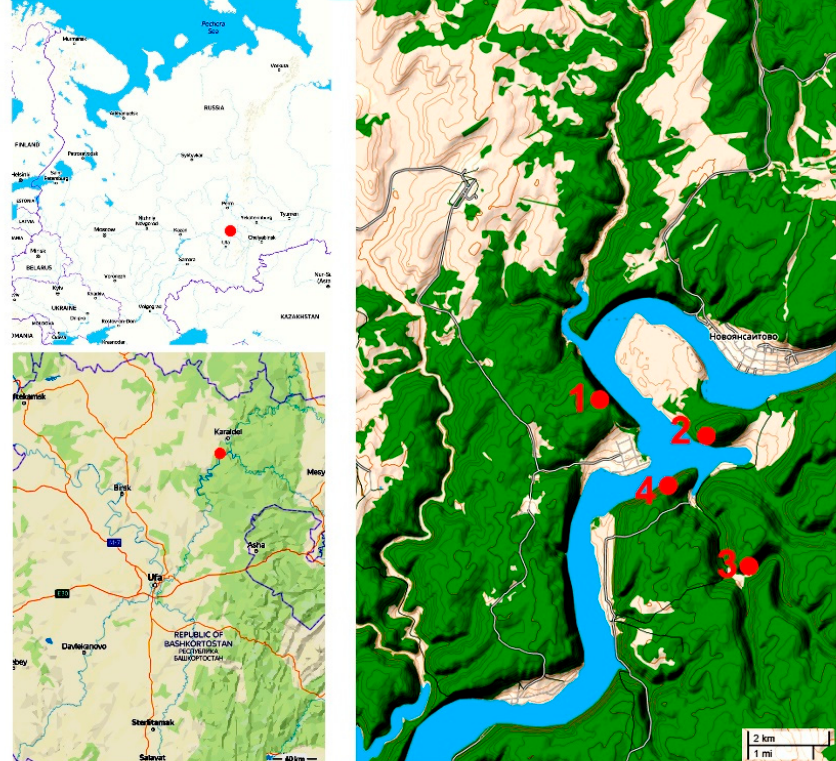
Figure 1. ( Left ): location of the study area on the Ufa plateau (red points); ( right ): the position of the spruce–moss forest (1), fir–spruce–moss forest (2), pine–moss forest (3), and larch–moss forest (4) around the Pavlovka Reservoir. Table 1. Description of the forest sites